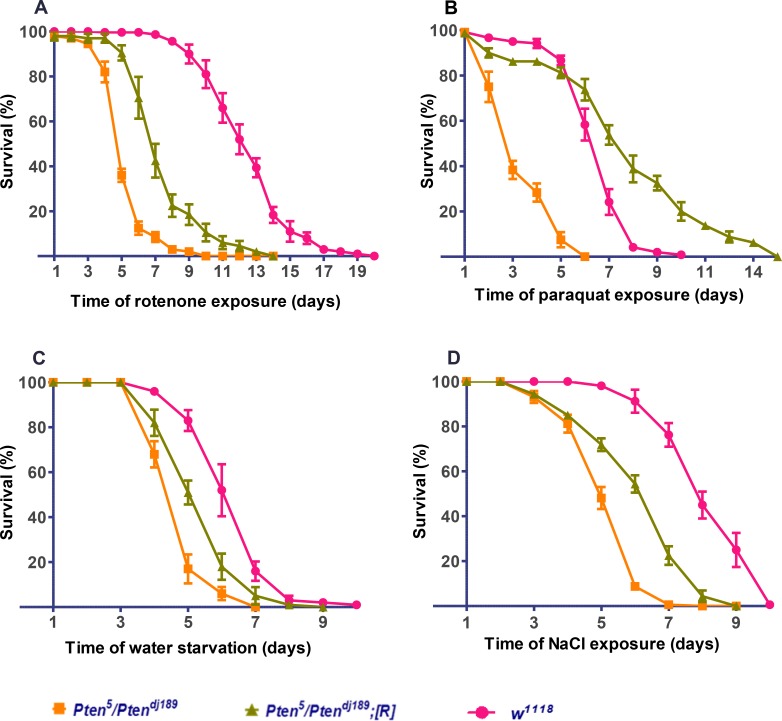

Pten
5 transheterozygous mutant flies are sensitive to a wide range of stresses.Survival of Pten
5
/Pten
dj189 transheterozygous mutants (orange), mutants carrying a Pten genomic rescue construct (Pten
5
/Pten
dj189
;[R]) (green), and wild type control w
1118 (pink) males after they were exposed to (A) 5mM rotenone, (B) 2mM paraquat, (C) water-only diet and (D) 500mM NaCl. The mean survival times (in hours) for Pten
5 transheterozygous mutants, rescue flies, and wild type control w
1118 flies respectively are: rotenone = 40.4, 89.2 and 107.1; paraquat = 8.6, 24.2, and 50.3; water starvation = 9.2, 19.1 and 24.2; NaCl = 15.4, 19.4 and 30.9. In all four stress assays, Pten
5 transheterozygous mutants were short lived compared with wild type w
1118 (P < 0.001), and for all but NaCl stress had a significantly shorter mean survival time compared to rescue flies (P < 0.01). For each experiment, flies were grouped into at least 6–8 batches of 20, these experiments were then repeated four times and data pooled together, n ≥ 480). Statistical significance was determined by Mantel-Cox Log rank test and Wilcoxon test using GraphPad5. Graphs presented as pooled data of percentage mean of survival for each genotype. Graphs presented as mean ± SEM.